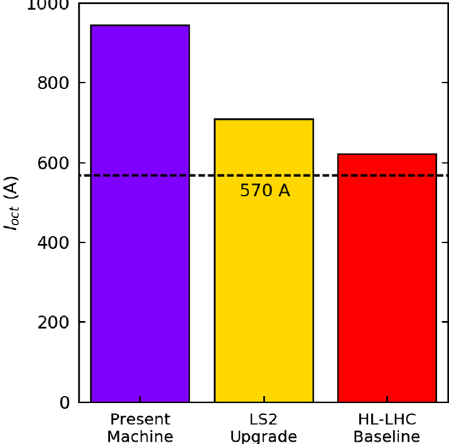
FIG. 11. Novel coatings significantly improve the single beam octupole threshold. For the most critical BCMS beam up to ∼ 320 A is gained by upgrading 9 secondary and 2 primary collimators per beam in the present baseline ( “ HL-LHC baseline ” ) compared to the current machine ( “ present machine ” ). “ LS2 upgrade ” reflects the situation in Run 3 with 2 primary and 4 secondary collimators upgraded; it provides over a half of the overall improvement, about 250 A. E ¼ 7 TeV, Q 0 ¼ 10 , the situation in the most critical, horizontal plane is shown, assuming a factor 2 from the operational